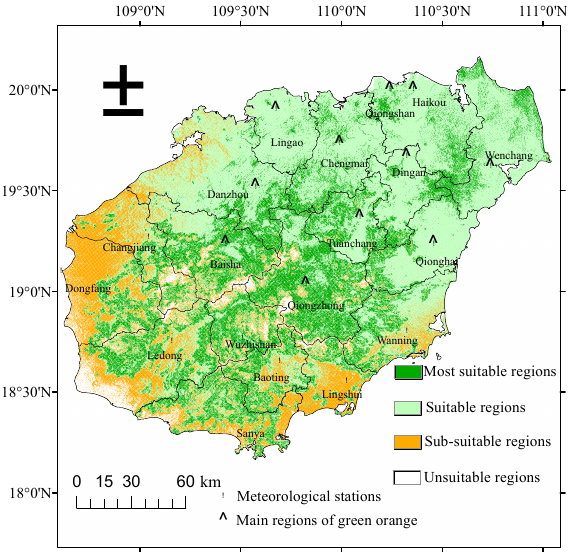
Figure 5. Climatic suitability zoning map for green orange in Hainan Island.